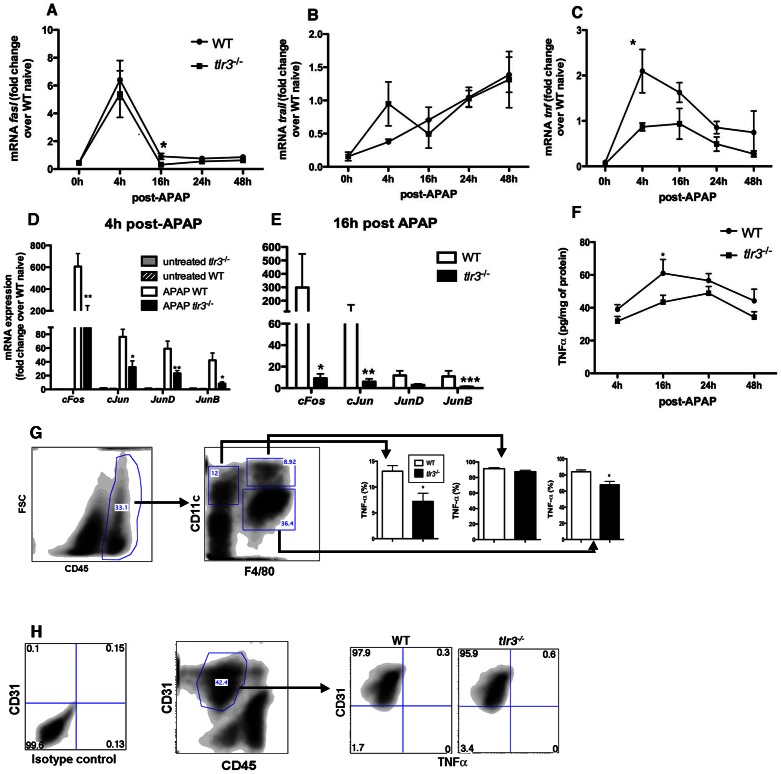
TLR3 modulates the expression TNFα after APAP.Total liver transcript levels of (A) fasl, (B) trail, (C) tnf and (D–E) AP-1 genes in WT and tlr3
−/− mice. (F) Total liver TNFα protein levels in WT and tlr3
−/− mice after APAP. Statistically significant differences are indicated (*p<0.05; **p<0.01 and ***p<0.001). Data are presented as the mean ± SEM of 2–3 independent experiments. (G–H) Percentage of TNFα+ cells in different liver cell populations isolated from WT and tlr3−/− mice at 24 h post APAP. Gating is indicated on the left, population statistics are indicated in the bar graph on the right. Rat IgG1, kappa light chain antibody was used as an isotype control for TNFα staining (Figure S7). Representative population of LSECs (CD45−CD31+) is shown. Data is representative of two independent experiments. Data represent mean ± SEM (n = 3/group in each experiment).